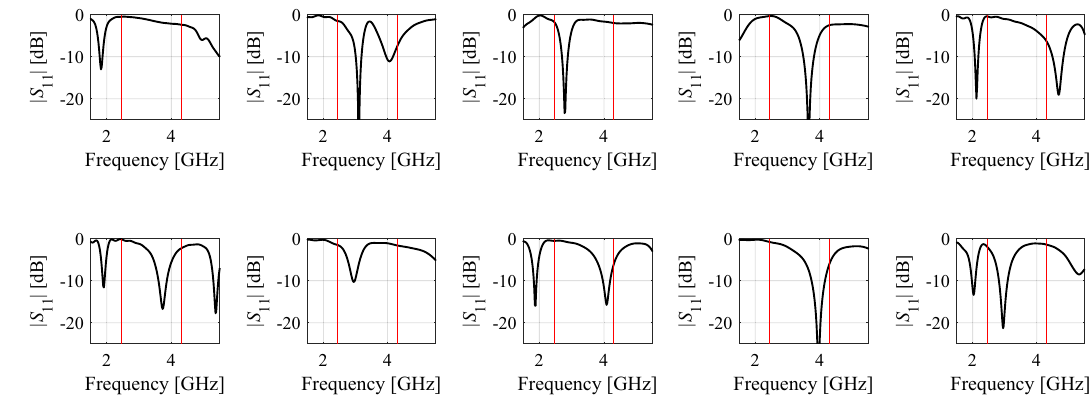
Figure 1. Exemplary reflection responses of a dual-band antenna along with the target operating frequencies marked using vertical lines (here, 2.45 GHz and 4.3 GHz). Launching the local search aimed at, e.g., reduction of the antenna reflection in the vicinity of the target frequencies (and formulated in a minimax sense), from the majority of the presented designs would likely not bring satisfactory results as a direct consequence of a deficient initial allocation of the reflection characteristic